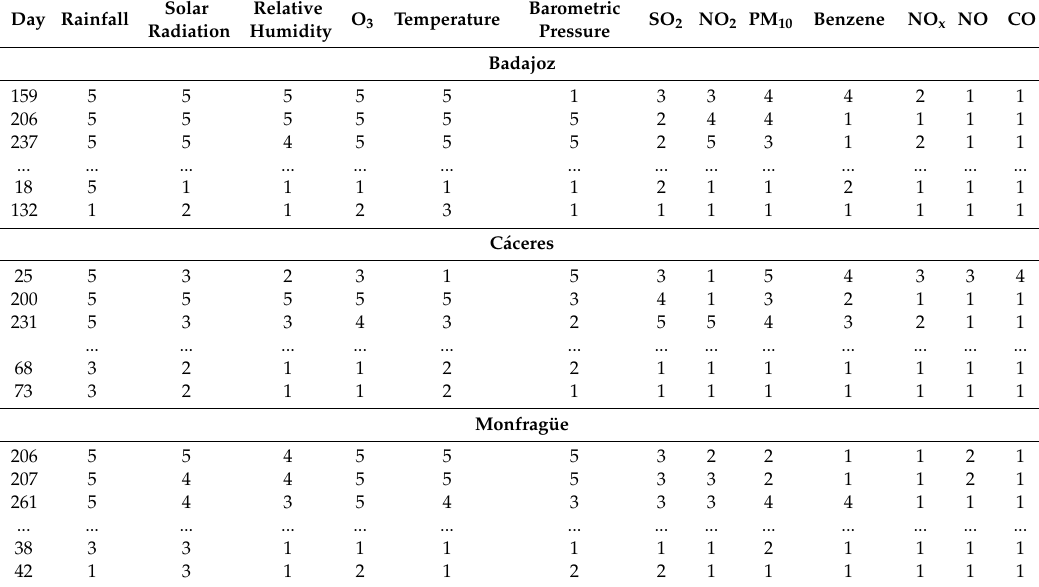
Table 5. Guttman scalograms for all individual pollutants and climatic factors (13) and days in 2016 considered. Only some days, those with higher and lower atmospheric pollution level, are shown for each